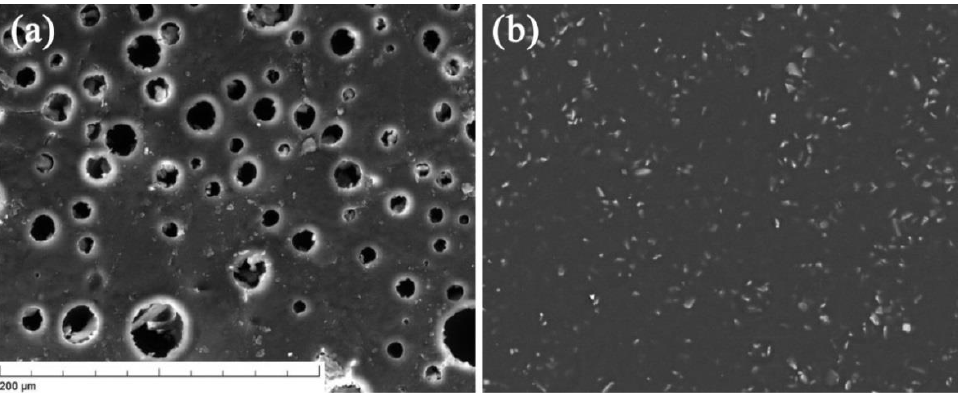
Figure 7. SEM images of ( a ) neat polyurea and ( b ) polyurea reinforced with irregular alumina par- ticles. Reproduced with permission from ref. [74].